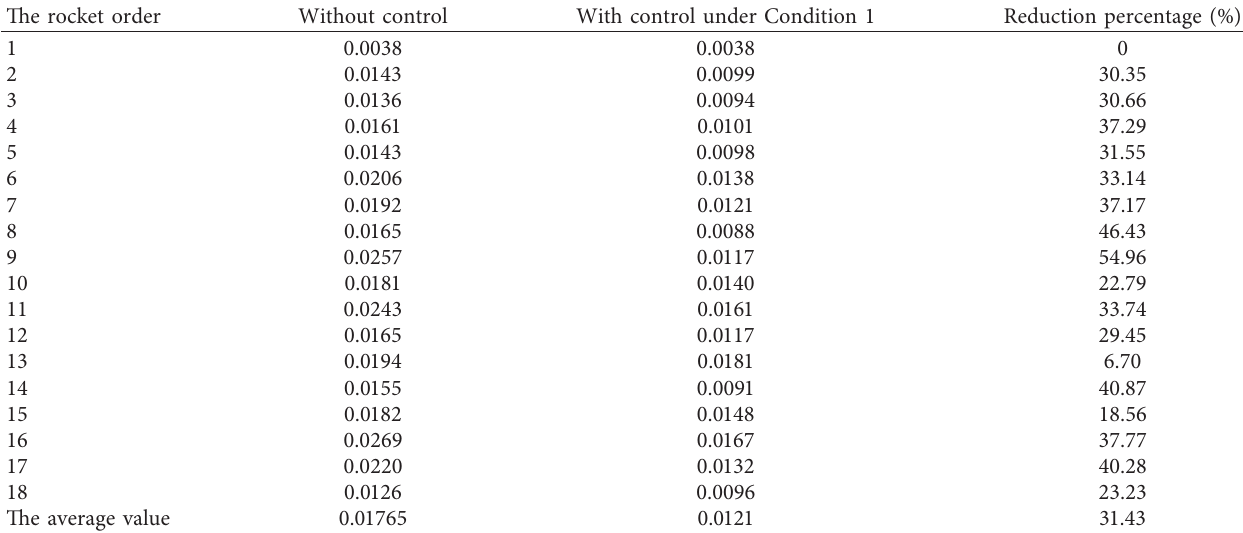
Table 2: Comparison of _ θ yz in the control period under Condition